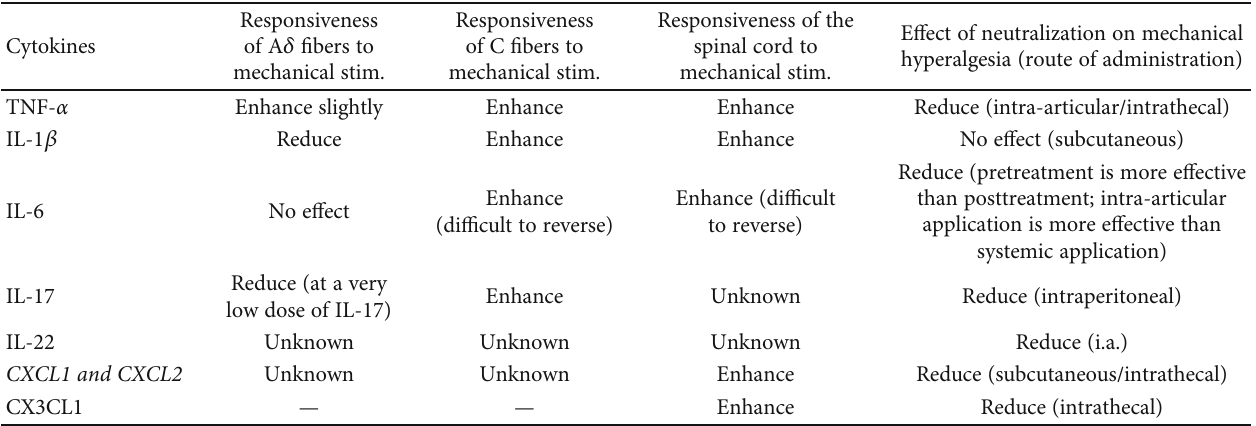
Table 1: After injecting di ff erent cytokines into normal knee joint, the changes of the responsiveness of the nociceptive sensory neurons (A δ and C fi bers) to the mechanical stimulation of the joint. The e ff ects of the intrathecal injection of cytokines on the responsiveness of the spinal cord induced by the joint mechanical stimulation and long-term e ff ects of the neutralization of these cytokines on pain behavior in the animal model.